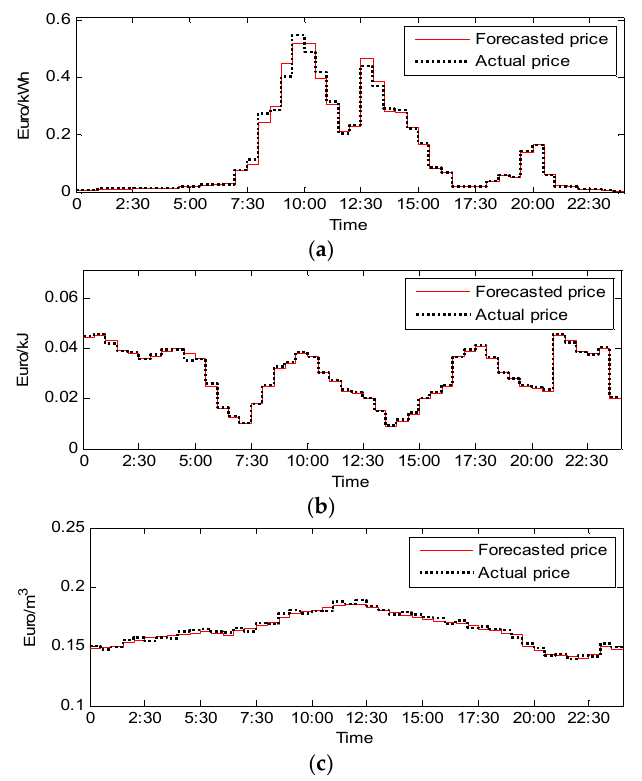
Figure 7. Actual and forecasted prices of electricity, heat, and natural gas. ( a ) Electricity price; ( b ) heat price; and ( c ) natural gas price.